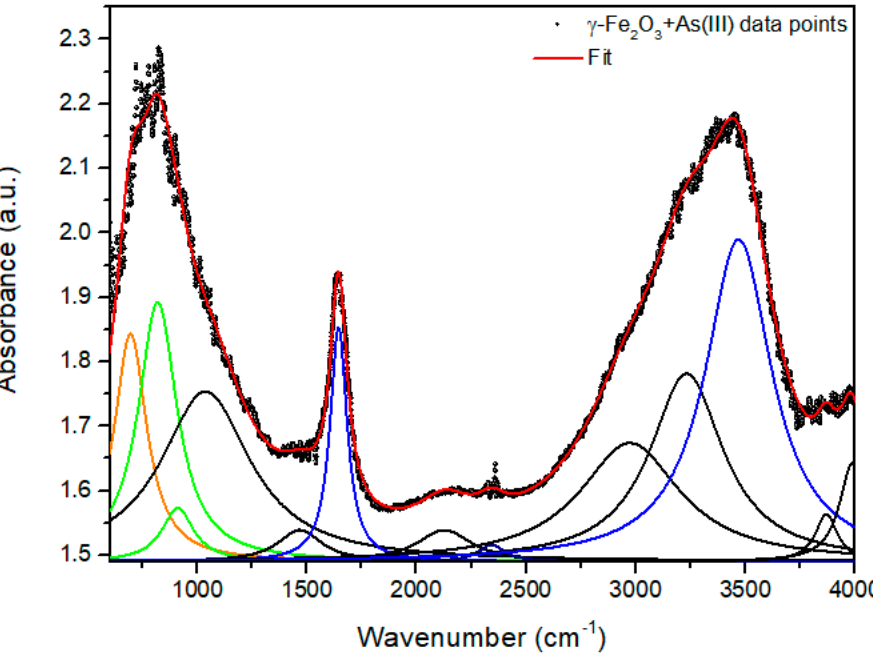
Figure 6. Fitted FTIR spectrum of the γ -Fe 2 O 3 NPs in As(III) solution. In the graph, the orange color indicates the Fe-O stretching mode, the green color to As-O, the blue color to O-H, and the black represents the background contribution. Figure developed by the